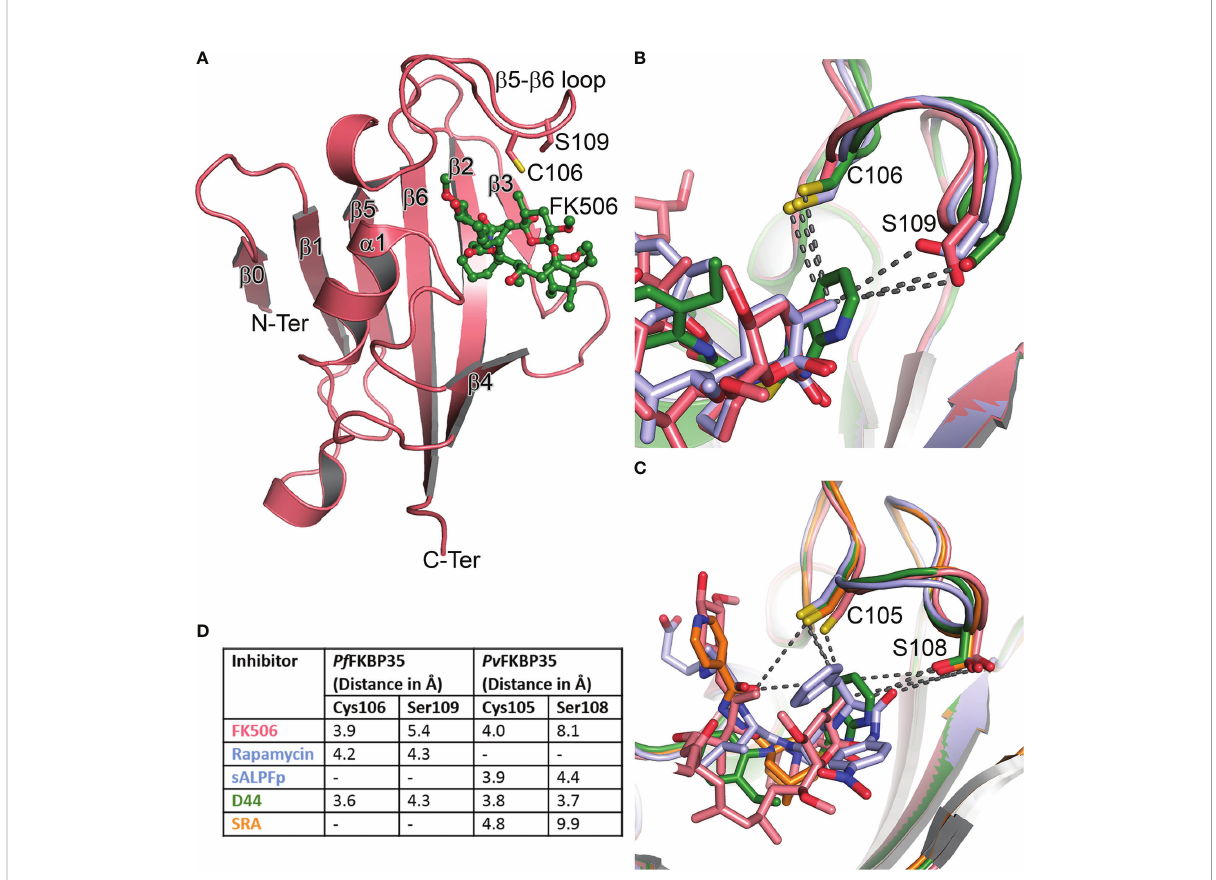
FIGURE 1 Structure and comparison of Plasmodium FKBPs. (A) The cartoon representation of Pf FKBD35 in complex with FK506 (in ball and stick mode). The b 0 observed here is not present in hs FKBPs. Similarly, the two unique residues pertaining to Plasmodium FKBP35 ’ s Cys106 and Ser109 in the b 5- b 6 loop are shown in stick mode. (B) The overlay of FK506 (salmon), rapamycin (pale blue) and D44 (green) bound structures of Pf FKBD35, with the nearest atom from Cys106 and Ser109 shown in broken lines. (C) Similarly, the overlay of FK506 (salmon), substrate-ALPF (pale blue), D44 (green) and SRA (orange) bound structures of Pv FKBD35. (D) The nearest distance between the ligands and the unique Cys and Ser residues are listed for comparison, indicating the D44 is oriented closer to these